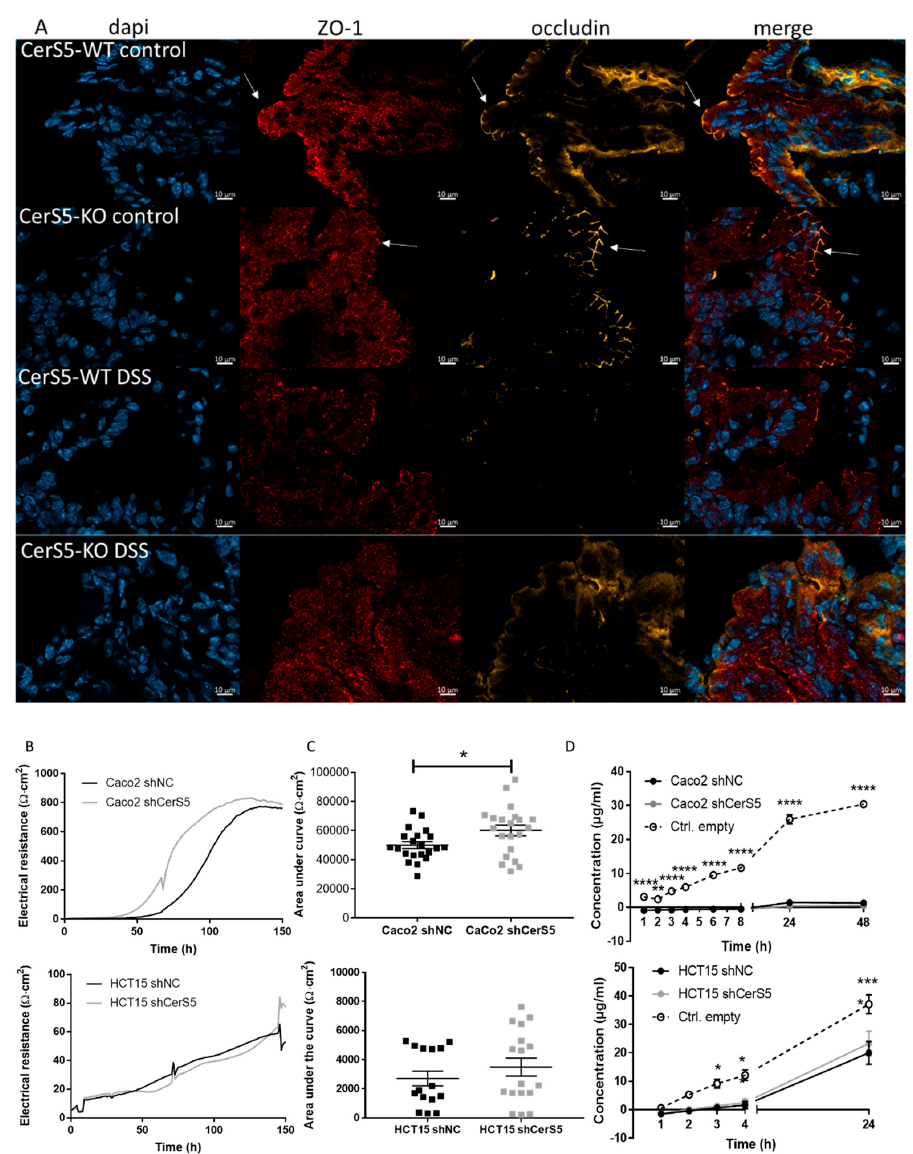
Figure 4. Influence of CerS5 on colon epithelial barrier. ( A ) Immunohistochemical staining of occludin and zonula occludens (ZO ‐ 1) in colon tissue from CerS5 ‐ wt and CerS5 ‐ ko mice. Slices, 10 μ M in size, were fixed with Paraformaldehyde (PFA) and stained with anti ‐ ZO ‐ 1 antibody and secondary Alexa Fluor 647 ‐ anti ‐ rabbit antibody, anti ‐ occludin ‐ antibody and secondary Cy3 ‐ anti ‐ mouse antibody, and